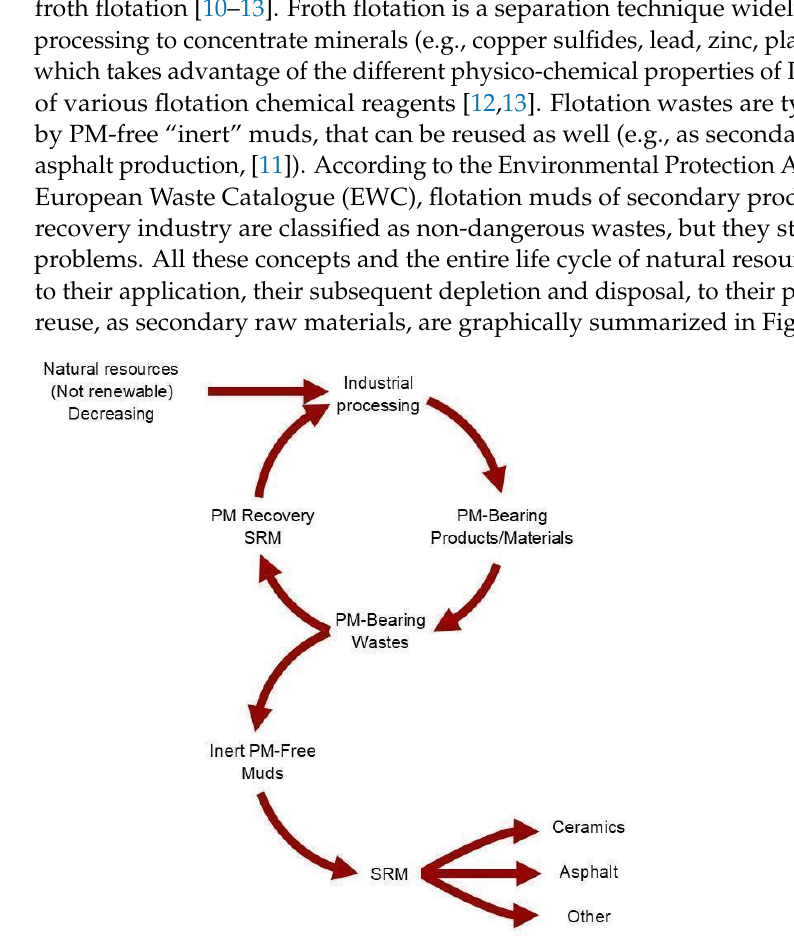
Figure 1. PM waste’s life cycle